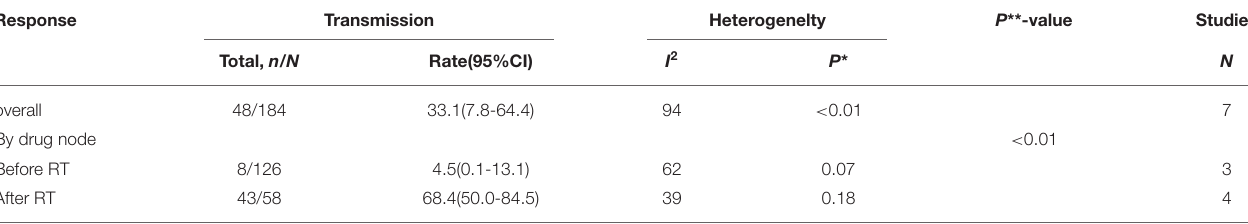
TABLE 6 | Transmission by drug